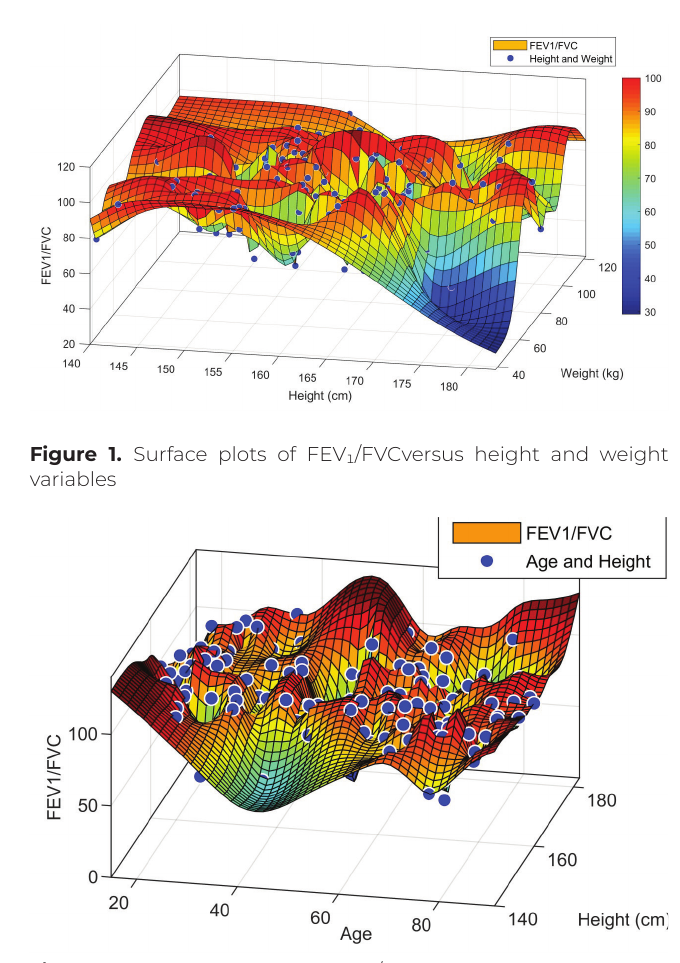
Figure 2. Surface plots of FEV1/FVCversus age and height variables